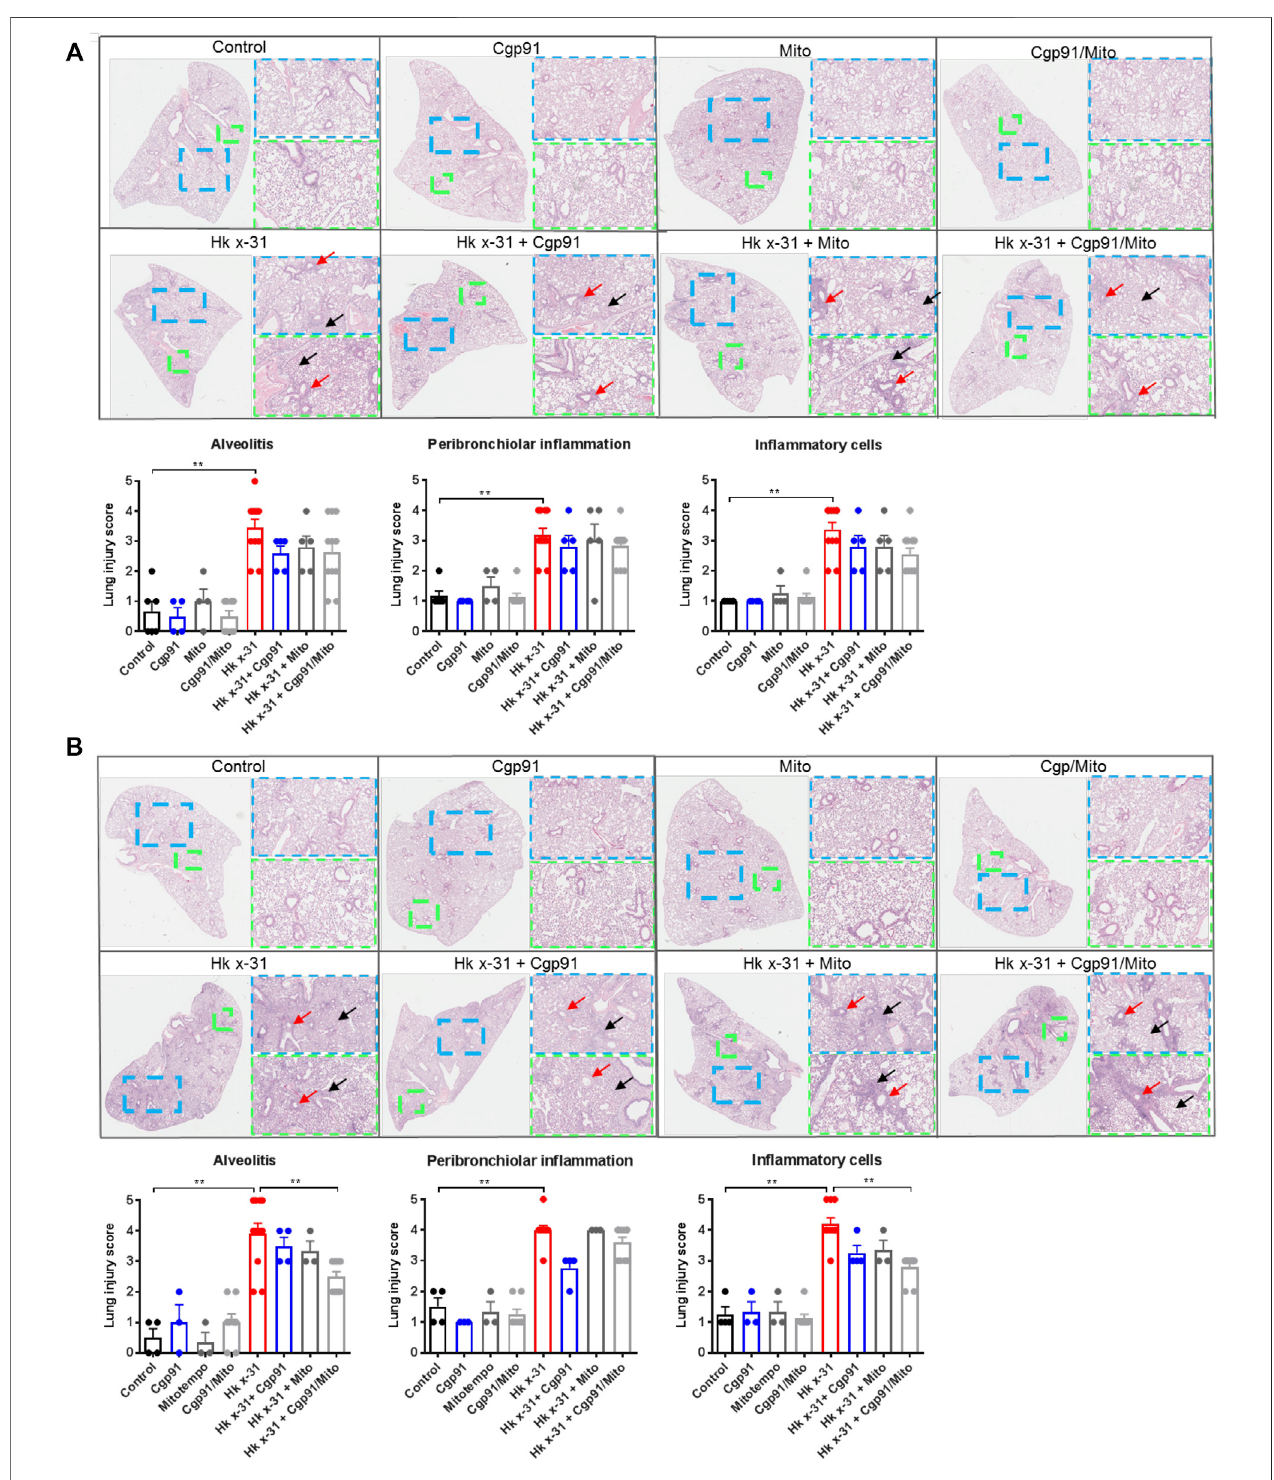
FIGURE 2 | Dual inhibition of endosomal and mitochondrial ROS reduces lung pathology in IAV infected mice. Histopathological analysis of lungs from C57Bl/6J micethatwereinfectedwithHkx31(10 4 PFUs)orPBS via intranasaladministration.Animalsweretreatedoncedaily1-dayfollowinginfection via intranasaladministration with Cgp91ds-TAT (0.2 mg/kg) and mitoTEMPO (100 µg) in combination or individually over a 2 days period at (A) day 3 pi and (B) day 6 pi. Representative images displayinglung in fl ammation from paraf fi n embedded lungs were sectioned (10 μ m) longitudinally and stained with H&E. Each sample wasscored blindly from 0 – 5 for each individual mouse (higher numbers indicate increased severity) from two independent assessors. Sections were scored for alveolitis (red arrows), in fl ammatory cellin fi ltrateandperibronchiolarin fl ammation(blackarrows).Representativeimagesarepresentedatthreedifferentmagni fi cations[×1(clear),×3(blue),×6(green)].Data areexpressedasmean±SEM.Statisticalanalysiswasconductedusingnon-parametricMann-Whitneytest.Statisticalsigni fi cancewastakenwhere p < 0.05(*denotes p < 0.05 and ** p < 0.01). Frontiers in Pharmacology |